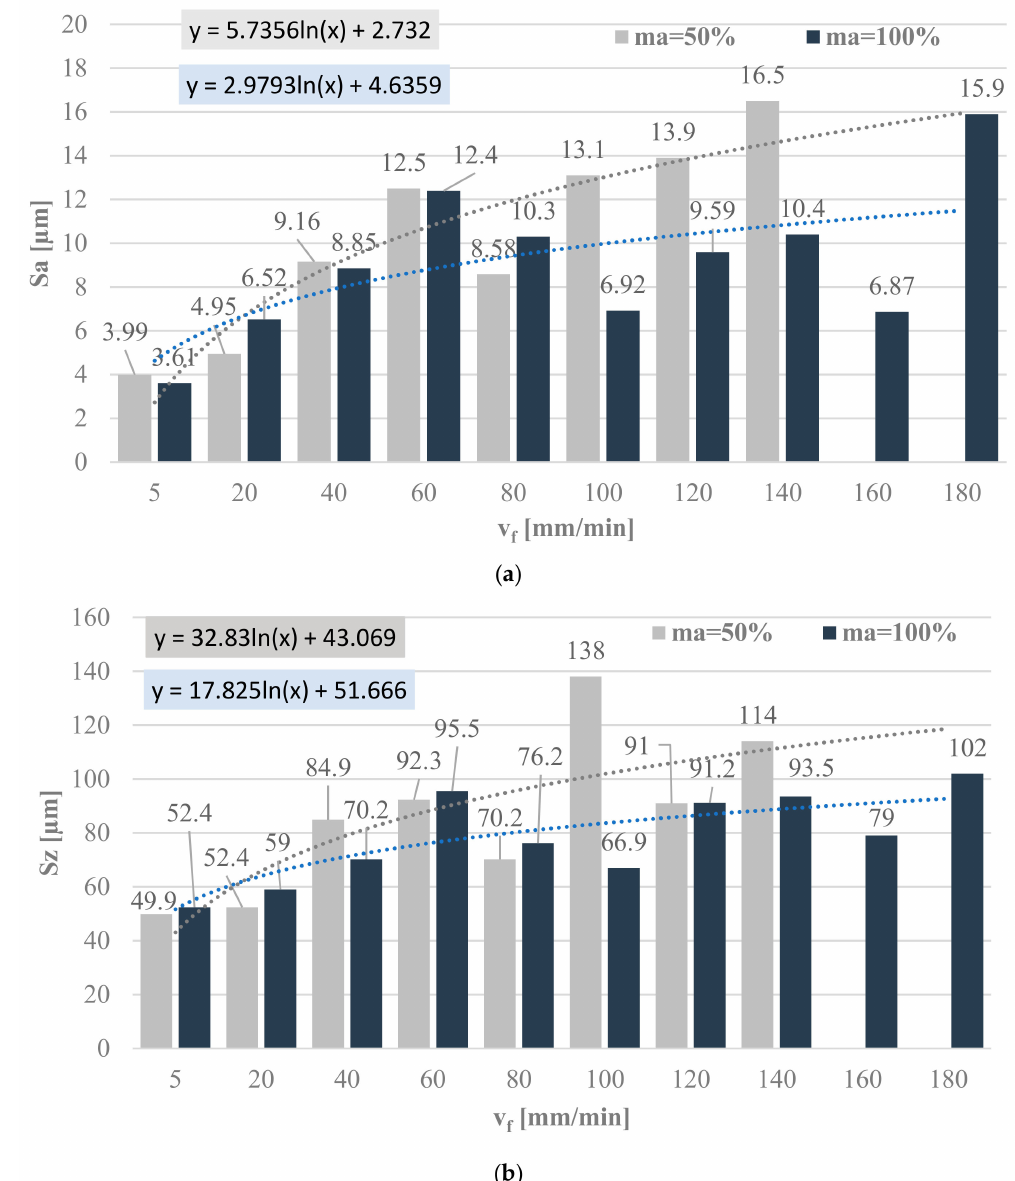
Figure 11. 3D area roughness parameters: ( a ) Sa and ( b )